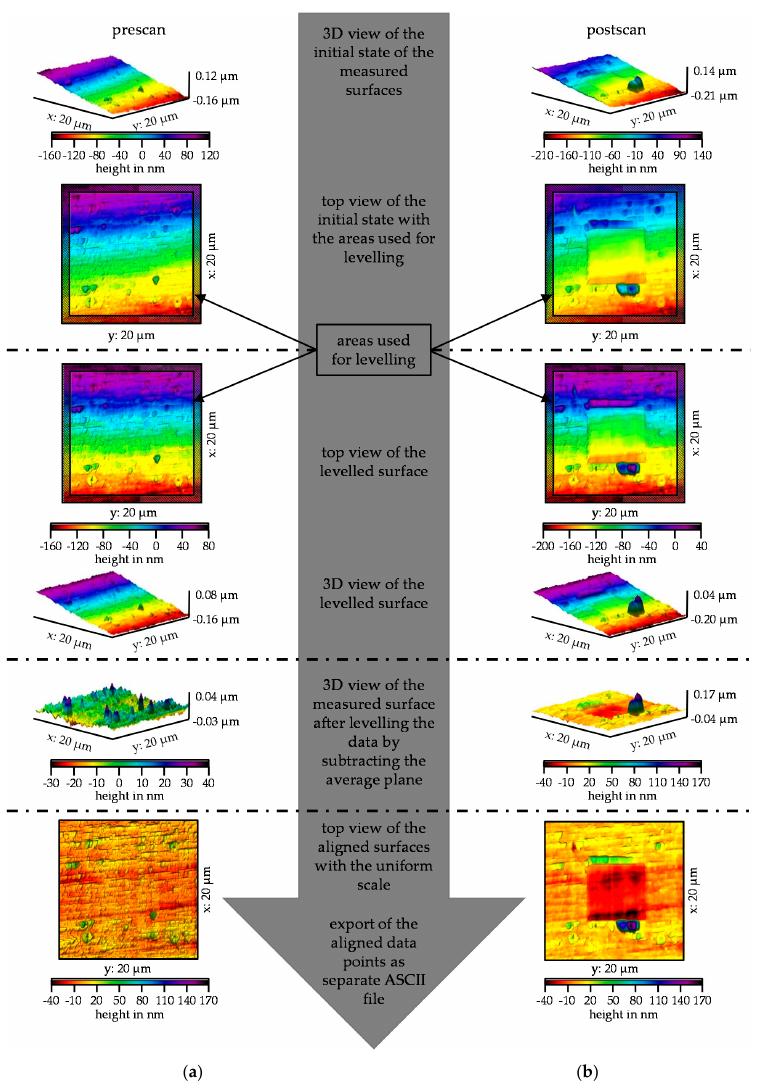
Figure 4. Gwyddion ® workflow of the standardized transformation steps and their effects on the surface of ( a ) The pre-scan and ( b ) The post-scan on the MoO 3 specimen. In Figure 5, the determination of the offset (a) and its effect on the pre-scan and post-scan (b) in MATLAB ® are shown. The top overlaying 3D plot shows the position of the data extracted from the ASCII files from Gwyddion ® . The post-scan indicates slightly larger values in the z-direction than that of the pre-scan, which can also be seen in